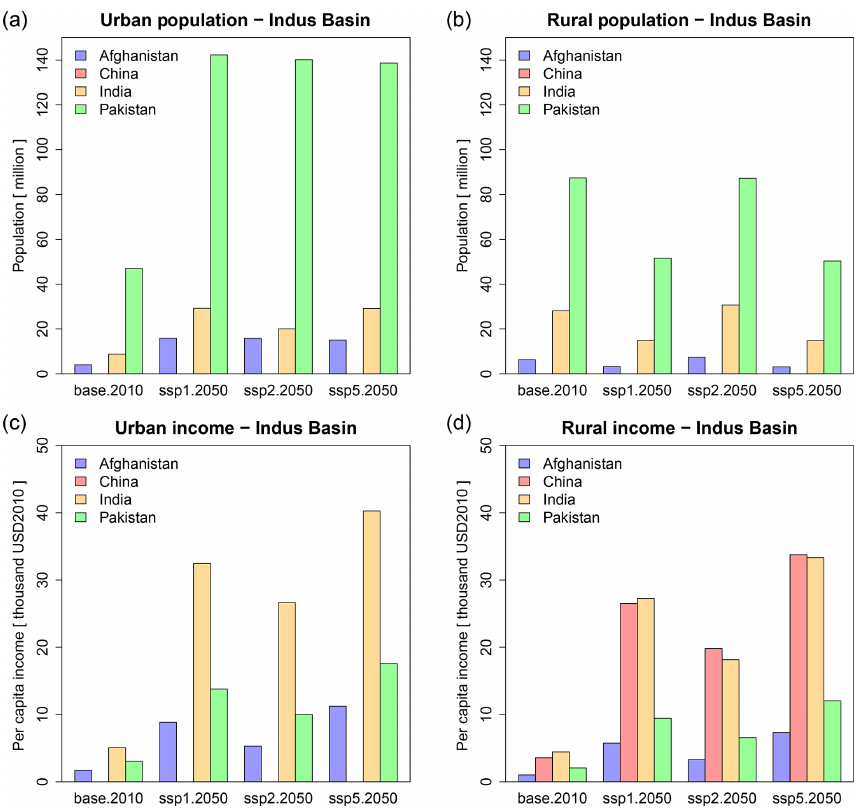
Figure 8. Urban and rural population (a, b) and per capita income (c, d) for SSP1, 2 and 5 in 2050 and 2010 for each riparian country’s part of the